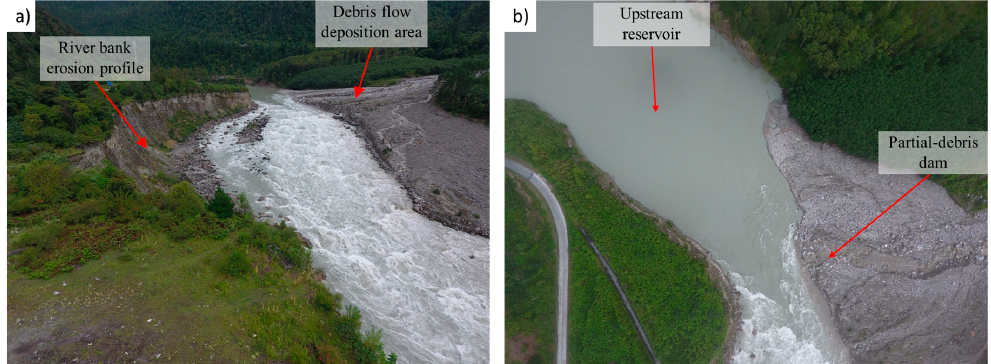
Figure 2. Field investigation of ( a ) river bank erosion profile; ( b ) upstream reservoir (unmanned aerial vehicle (UAV) photo taken on 12 September 2017).